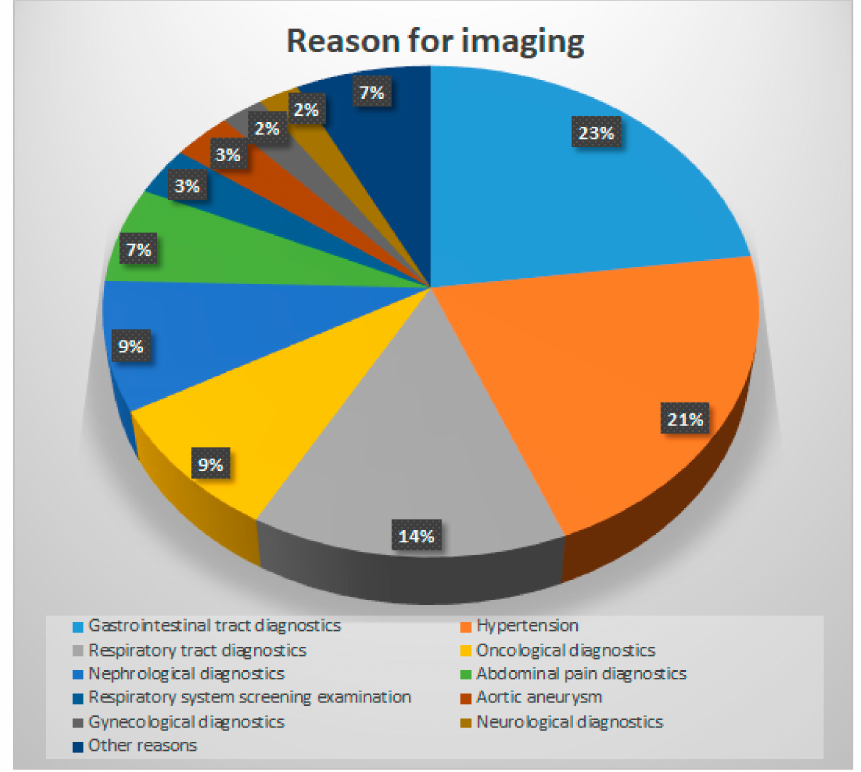
Figure 1. Causes for the first imaging examination, which revealed the presence of adrenal incidentaloma. Unilateral lesions were predominant (demonstrated in 1552 patients which accounts for 77.4% of AIs). Most AIs were diagnosed by means of CT scan. Lipid-rich adenomas were predominant (2044 tumors, 81.8%), while lipid-poor adenomas (327; 13.1%) and non-adenomas (92; 3.7%) were less